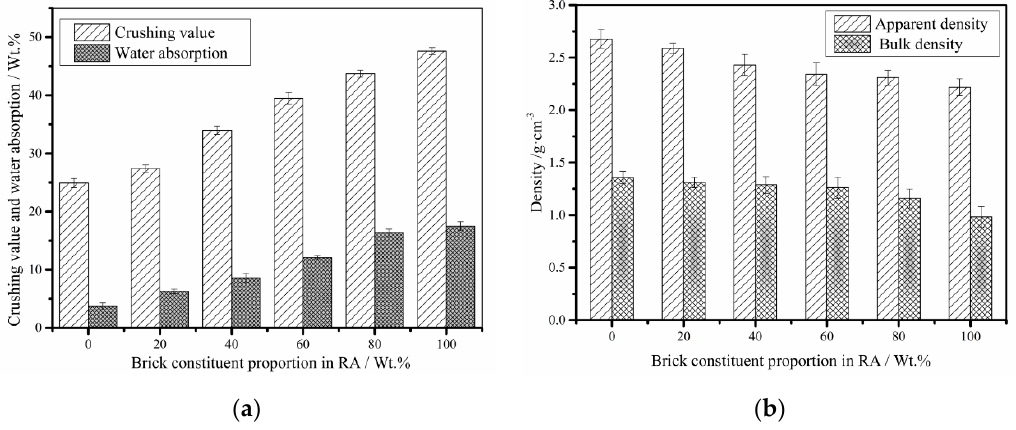
Figure 8. Indexes of MRA with brick proportion variations (AASHTO T 19M/T 19): ( a ) Crushing value and water absorption; ( b ) Apparent density and bulk density.